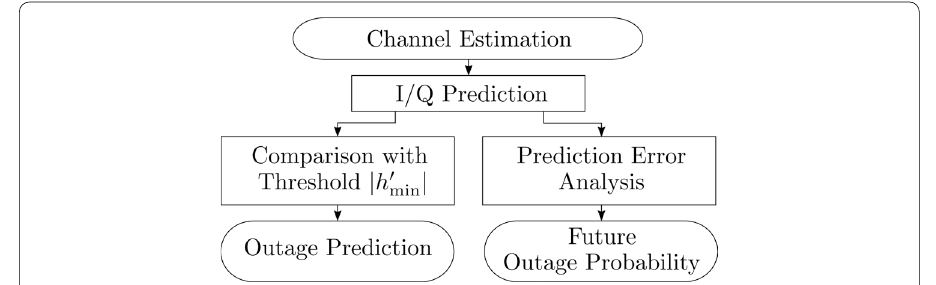
Fig. 4 Structure of the outage predictor for Rayleigh